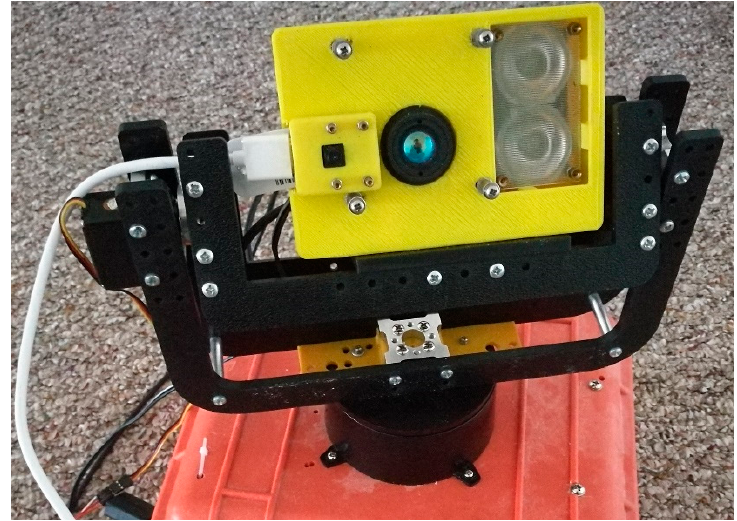
Figure 1. A fusion scanning system (FSS) with light emitting diode detection and ranging (Leddar) and monocular camera sensors.